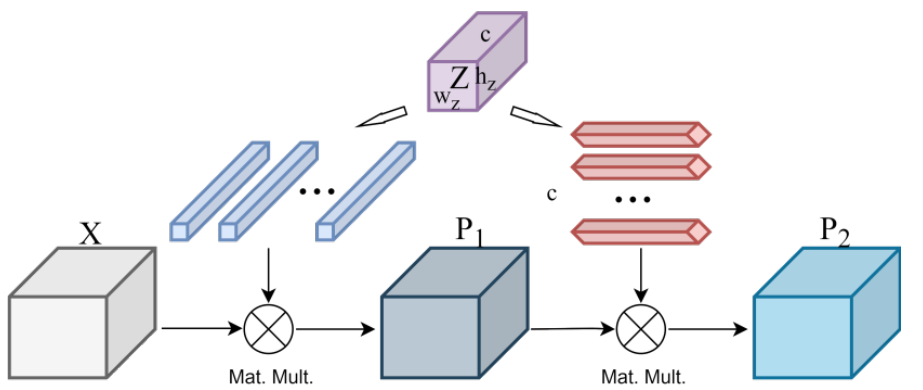
Figure 4. The process of pixel matching. First, calculate the similarity between each pixel point of the search feature and the spatial kernel, and then calculate the similarity between it and the channel kernel.